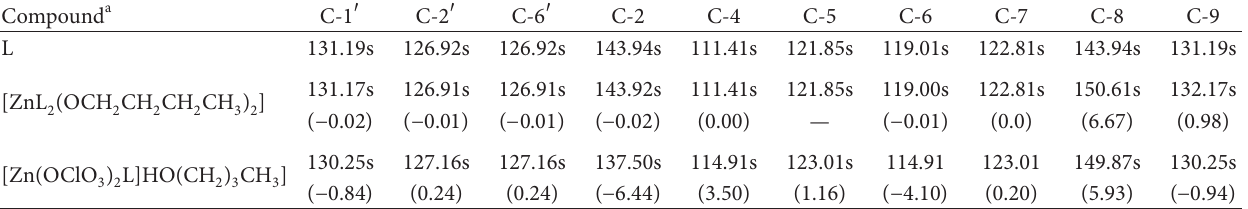
T 3: 13 C-NMR spectral data of the ligand and complexes (in